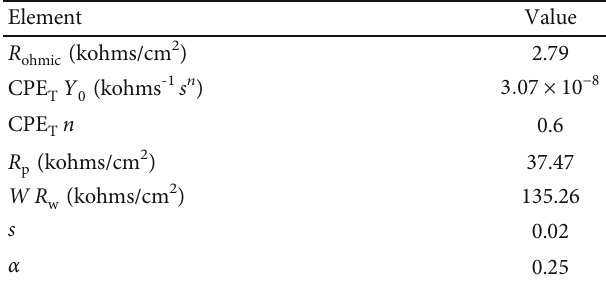
Table 3: Fitting parameters for EIS spectrum of the device. Element Value R (kohms/cm 2 ) 2.79 ohmic Y CPE (kohms -1 s n T 0